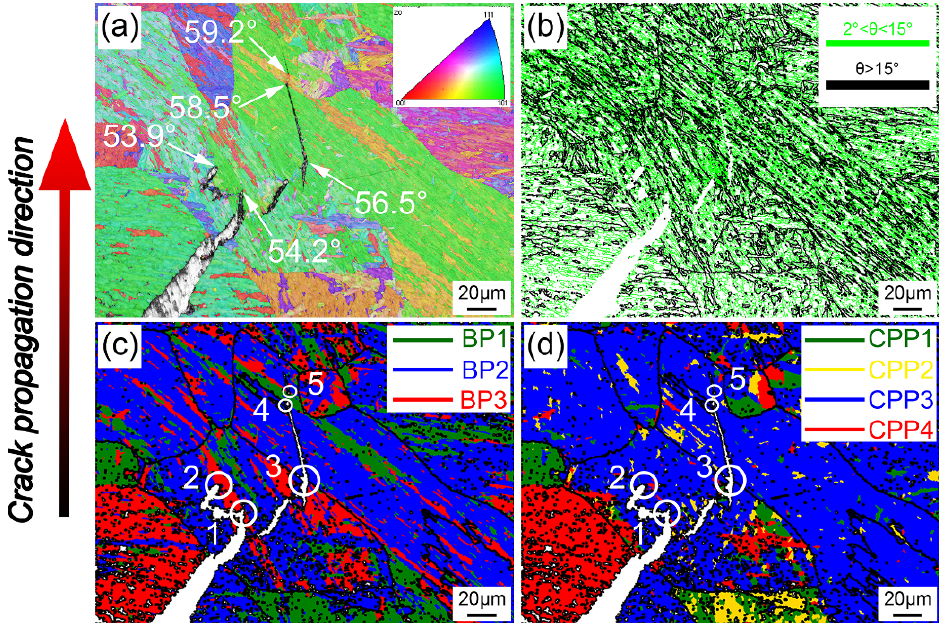
Figure 16. The analysis of crystallographic characteristics of the second crack propagation path in Ni7.5. ( a ) IPF map; ( b ) misorientation of grain boundary map; ( c ) the Bain packet (BP) map; ( d )